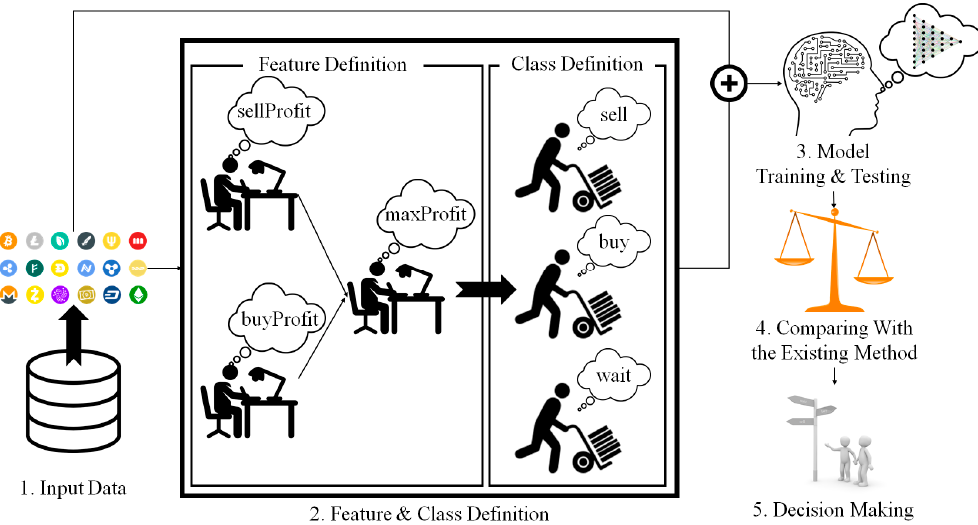
Figure 1. Overall approach of the proposed method.